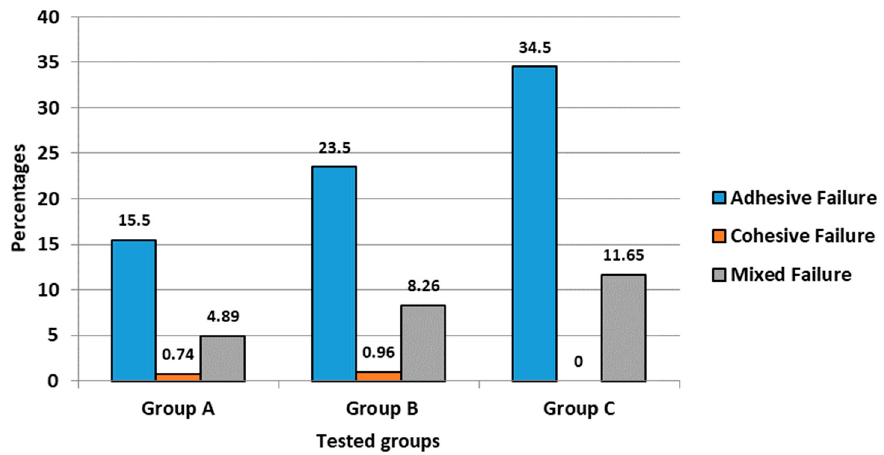
Figure 6. Analysis of failure modes for the three tested groups.